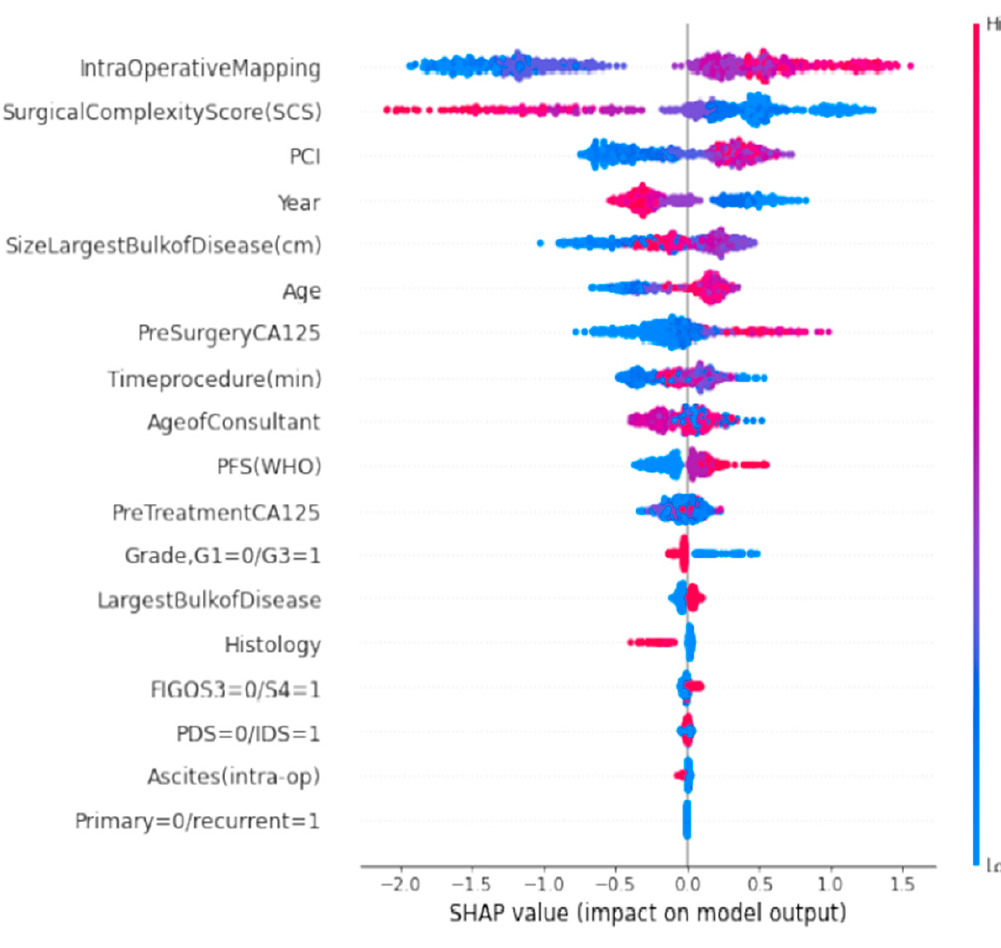
Figure 2. A set of beeswarm plots for global explainability of CC0 resection prediction. Dots correspond to the individual EOC patients in the study.